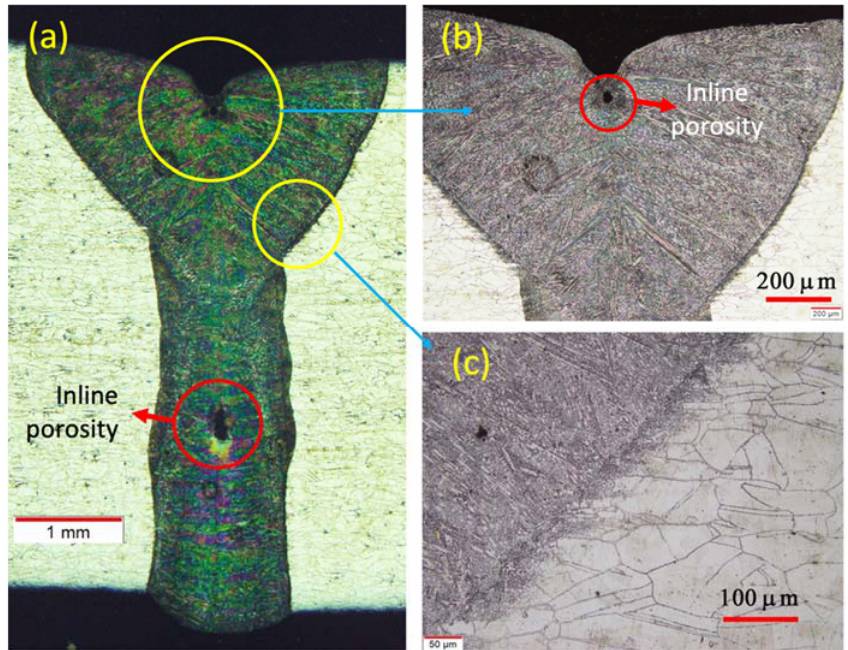
Figure 7. ( a ) Macrograph of Inconel 625 laser beam welded joint (weld 1) showing gas porosity on FZ and optical microscope images of the ( b ) weld cap and ( c ) HAZ. Table 3. Weld pool geometry as a function of heat